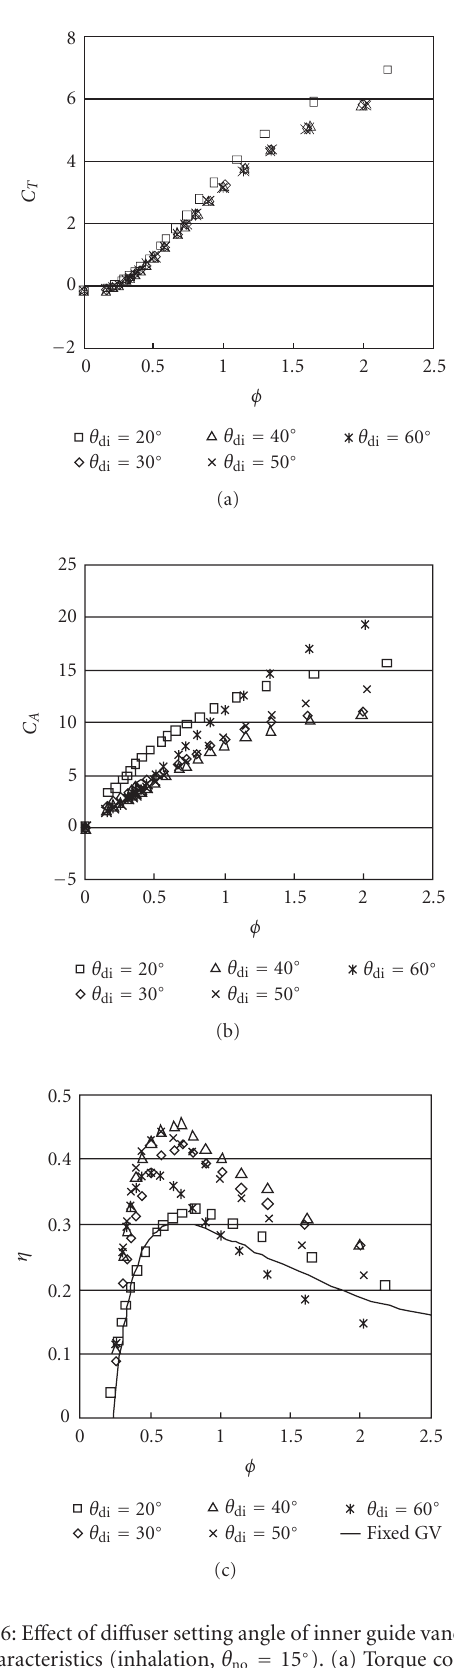
Figure 6: E ff ect of di ff user setting angle of inner guide vane on tur- bine characteristics (inhalation, θ no = 15 ◦ ). (a) Torque coe ffi cient. (b) Input coe ffi cient. (c) E ffi ciency.